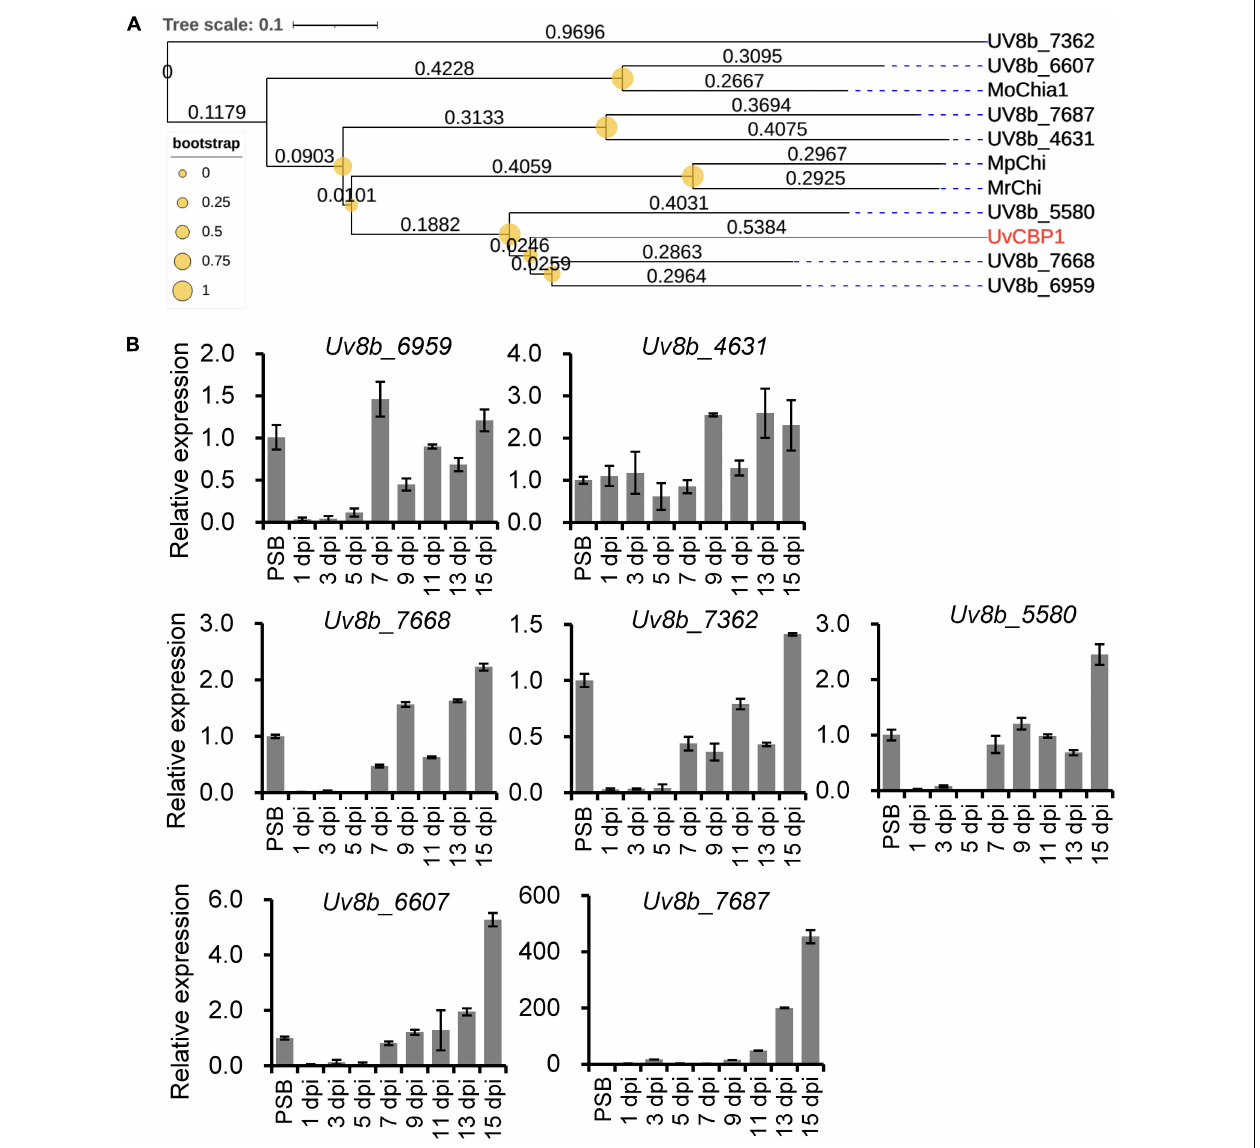
FIGURE 8 | Phylogenetic and expression analyses of UvCBP1 paralogs in U. virens . (A) Phylogenetic analysis of UvCBP1 paralogs in U. virens and other fungal pathogens. The size of yellow circles represent bootstrap values ranging from 0 to 1. The numbers represent branch lengths. (B) Expression analysis of paralogous genes of UvCBP1 during U. virens infection in rice. The mixture of mycelia and conidia from PS-cultured PJ52 was collected as the control sample. Relative expression levels of indicated genes were determined using UvTub2 α as the reference gene. Data are represented as means ± SD of three biological replicates. dpi, days post